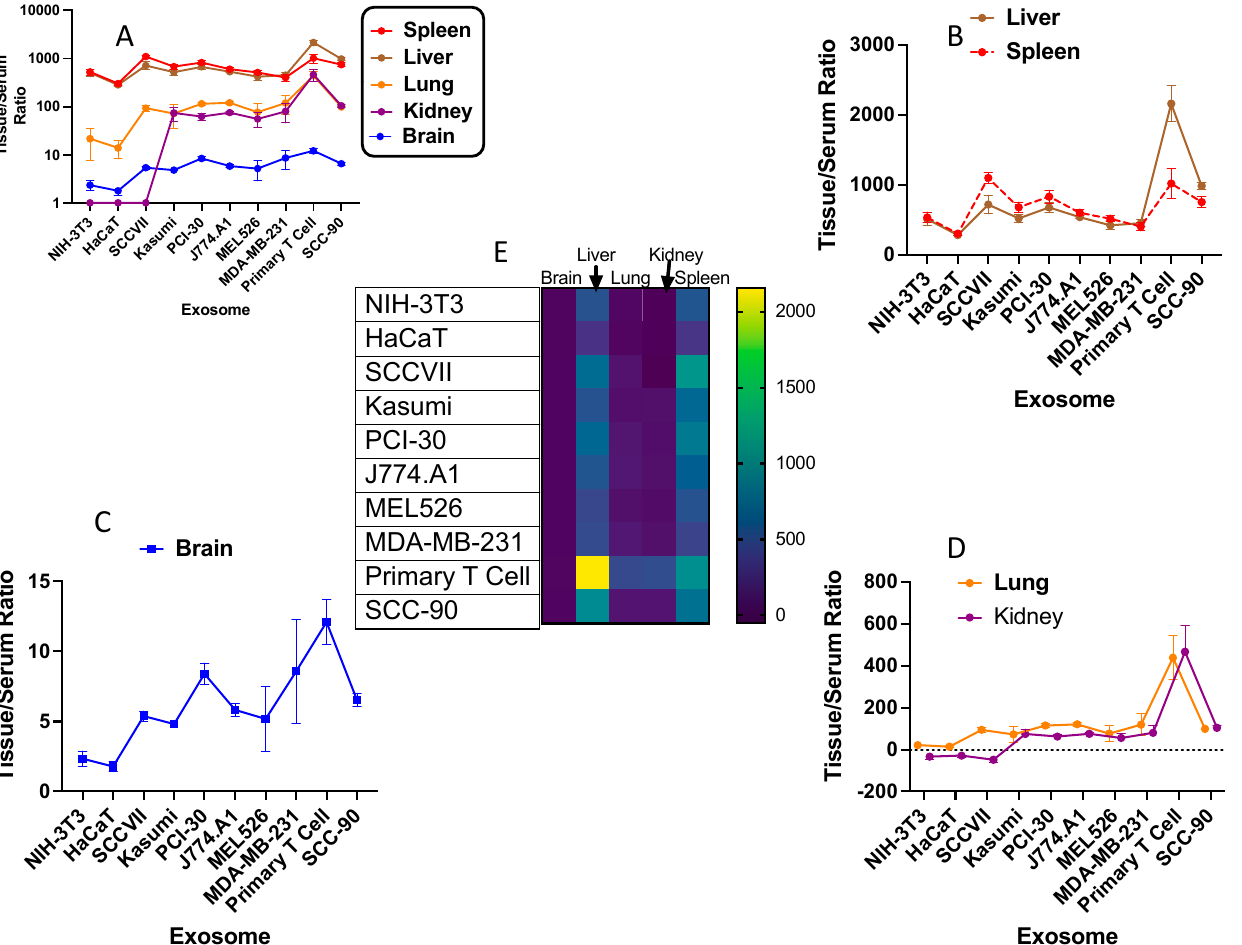
Figure 5. Comparison of exosome sequestration by various tissues. In ( A ) , the tissue/serum ratios for all tissues and all exosomes are shown in a logarithmic scale. NIH3T3, HaCAT, and SCCVII for kidney all had negative values but are plotted as a value of one. In ( B – D ), exosome sequestration by the five tissues is plotted in an arithmetic scale. In ( E ) , the heat map for all the data is presented. The data are means with SD and were obtained from mice used as controls for the WGA experiments which were studied 20 min after iv injection of the labeled exosome. Units in all panels are µL/g of tissue.